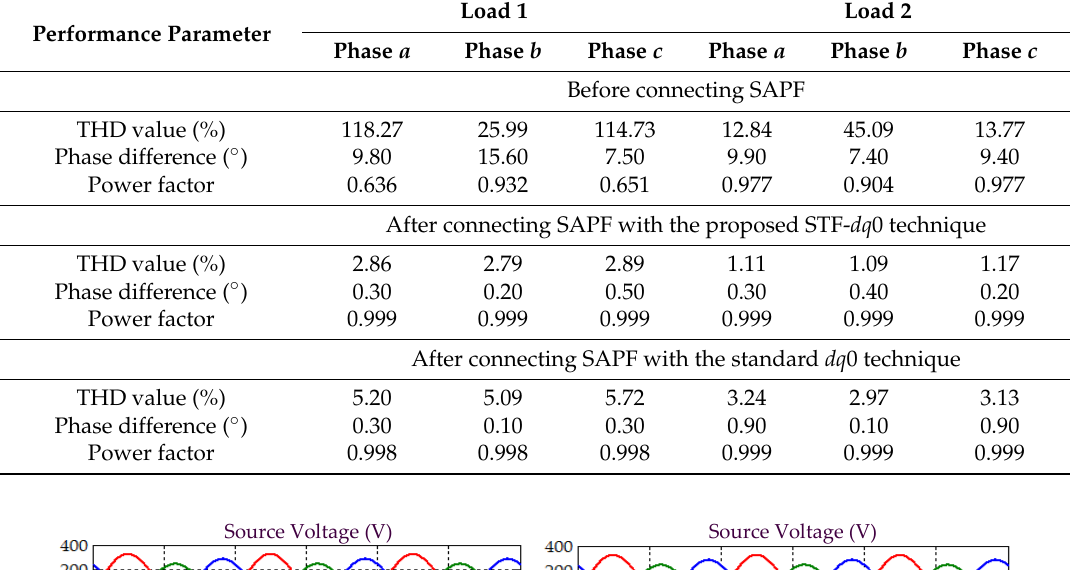
Table 4. Comparative analysis of the proposed STF- dq 0 and the standard dq 0 techniques under Scenario C.